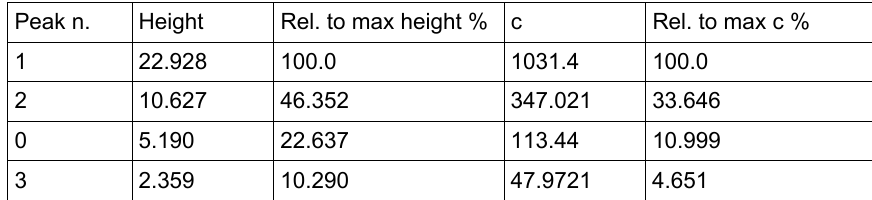
Table 5 – Heights and relative heights together with the c parameter and its relative values of peaks in Figure 1 Таблица 5 – Высоты и относительные высоты вместе с параметром c и